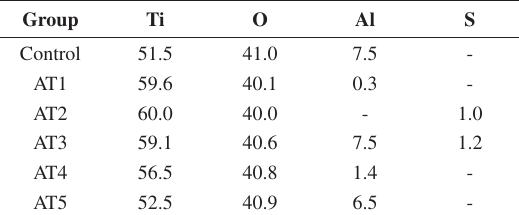
Table 3. Atomic concentration (%at) of elements according to the sample groups, as determined by EDS analysis (mean values from 3 samples).